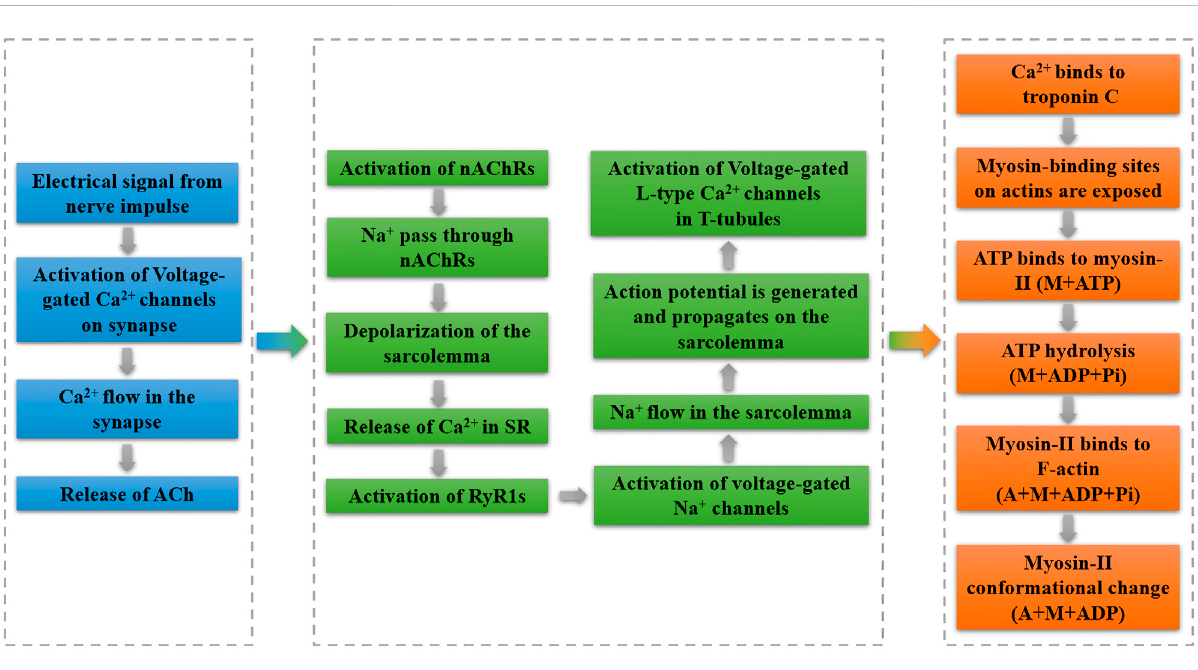
Process of muscle contraction. Part in blue represents the electrochemical signaling; part in green denotes the process of DICR; part in orange indicates the crossbridge model of actomyosin